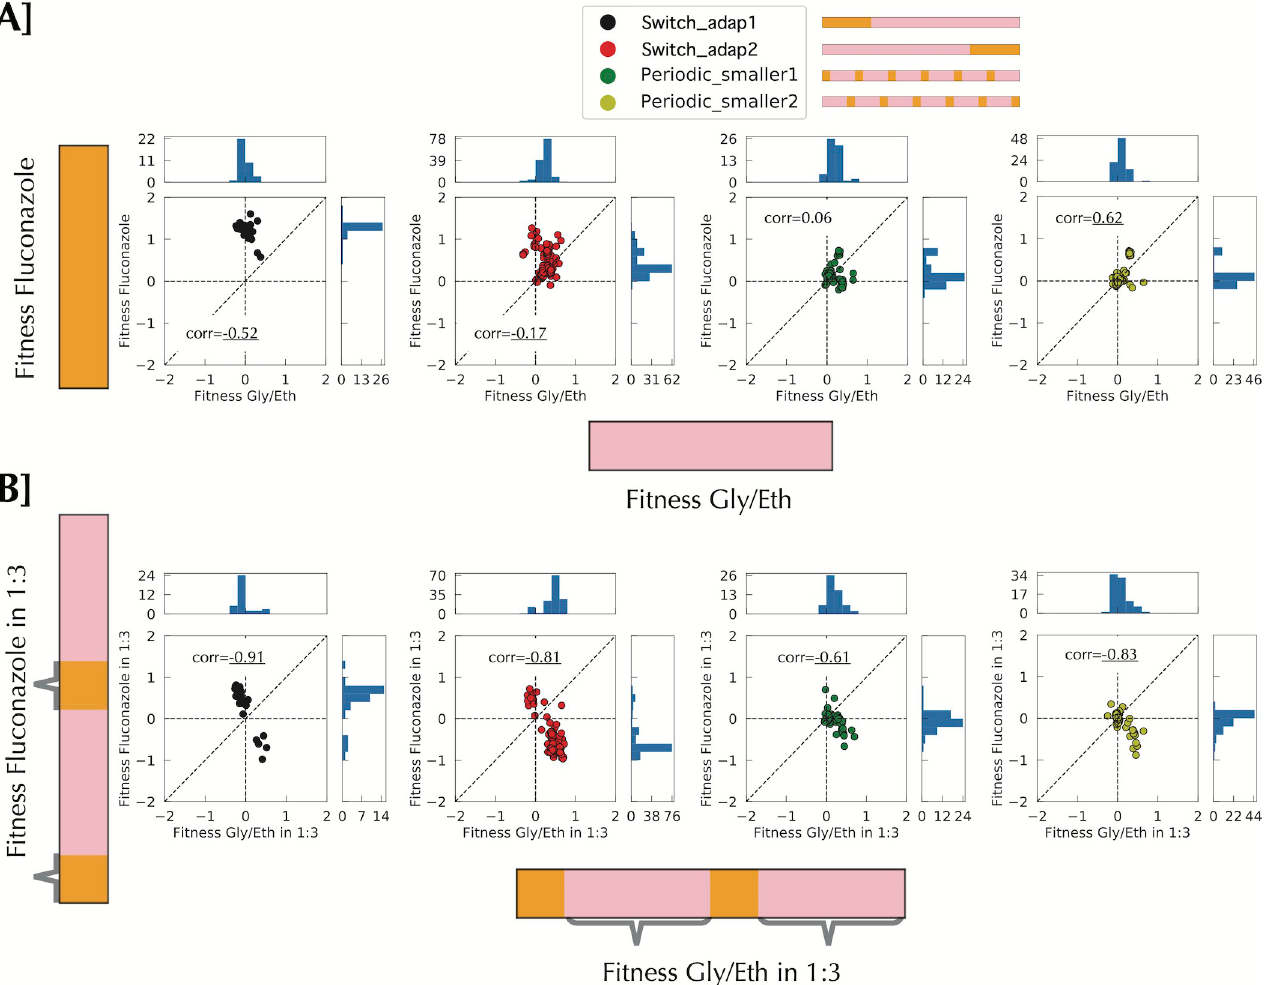
Fig 3. Fitness remeasurement shows different types of interaction between environments according to the time scale. All correlations are Pearson correlation. A] Fitness measurement for Gly/Eth and Fluconazole for 40 uninterrupted generations shows no particular correlation between environments . B] When fitness measurement is performed on a smaller timescale in the context of switching there is a net negative correlation between the two environments. Grey braces indicate when the fitness was measured.